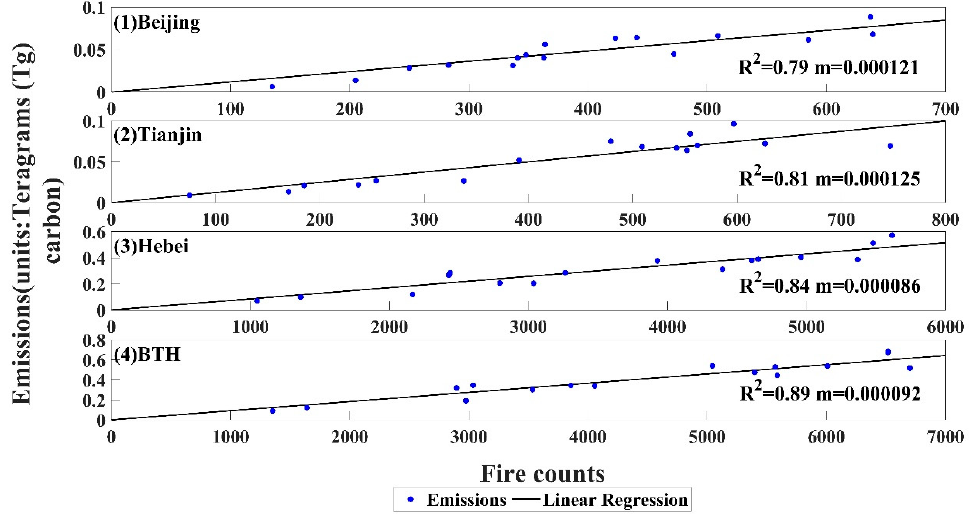
Figure 6. Linear relationship between fire counts and carbon emissions from 2003–2018.